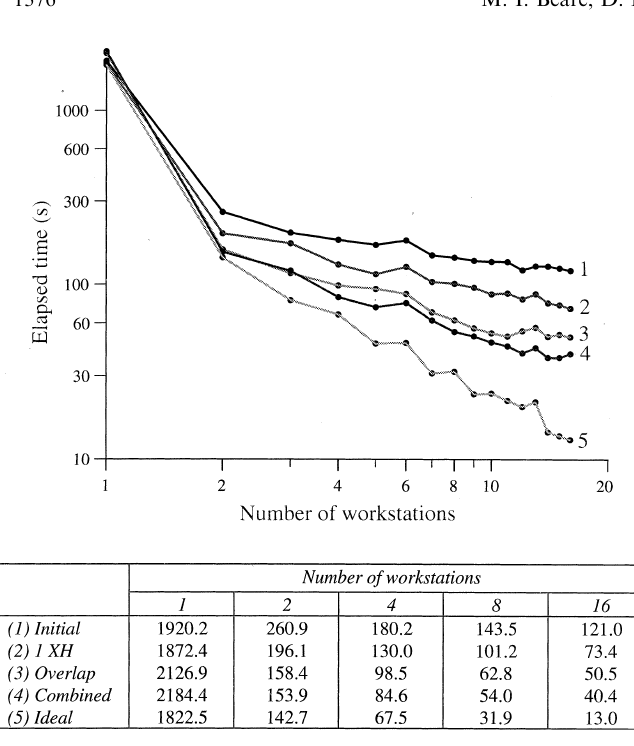
Fig. 8. Compared to (1) the initial implementation and the two separate optimisations, of (2) one extra free-surface halo and (3) overlapping communications with computation, it can be seen that by (4) combining the optimisations a notable increase in performance is again achieved